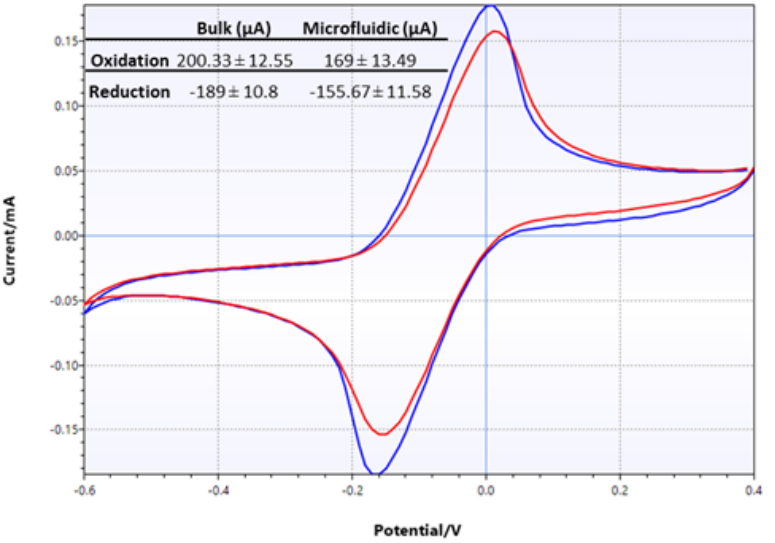
Figure 9. CV traces of LIG, comparing test results from bulk setting (blue) and microfluidic setting (red) performed with 10 mM potassium ferricyanide. The numerical data are shown in the inset table.